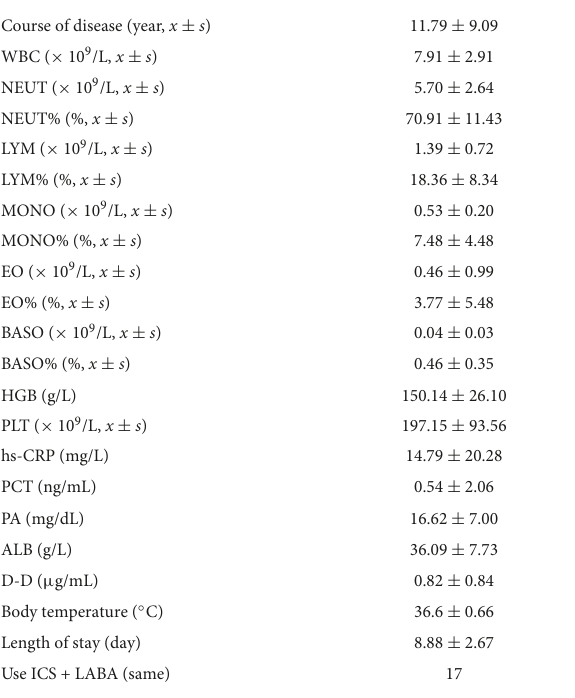
TABLE 1 Clinical information of acute exacerbation of chronic obstructive pulmonary disease (AECOPD)